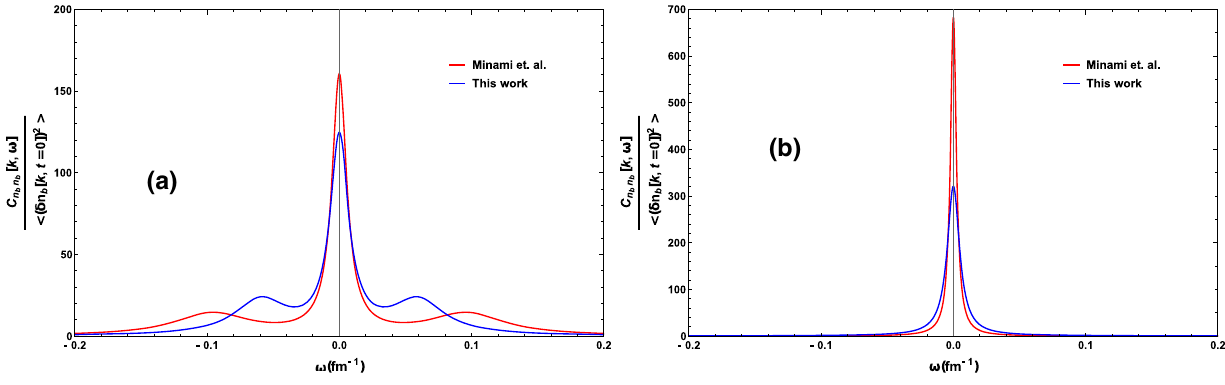
Fig. 1 Correlation function near the QCD critical point for k = 0 . 1 fm − 1 . We choose two representative vales of t = T − T c panel) and t = 0 . 1 (right panel). Red curve represents the results of Ref. [49] whereas the blue curve represents the results of this